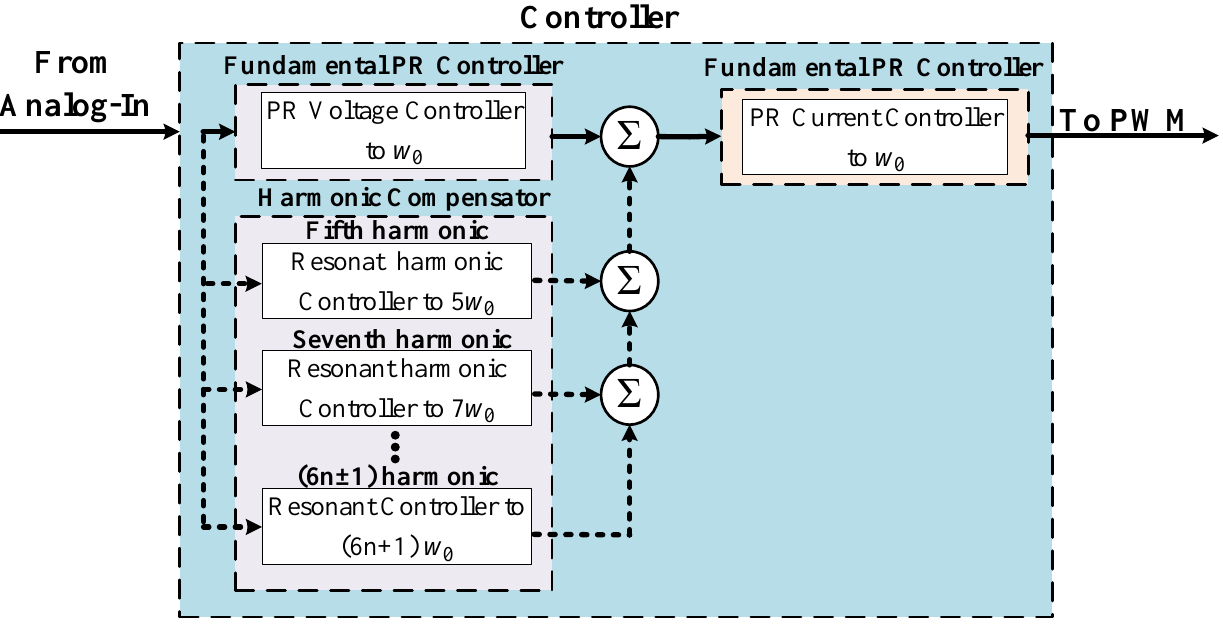
Figure 9. General structure of harmonics control in Matlab/Simulink for each